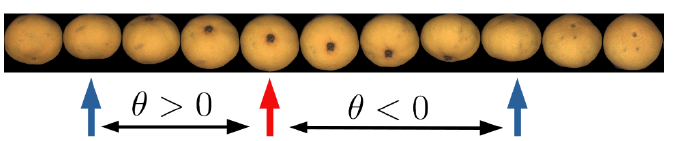
Figure 13. Sequence of views. Blue and red arrows indicate local minima and maxima respectively, of the sequence B = { b i } of the semi-minor axis. If the sequence B is increasing at instant i , then θ > 0. This means (for this direction of rotation) that the part below the fruit center in the view is higher than the part above the